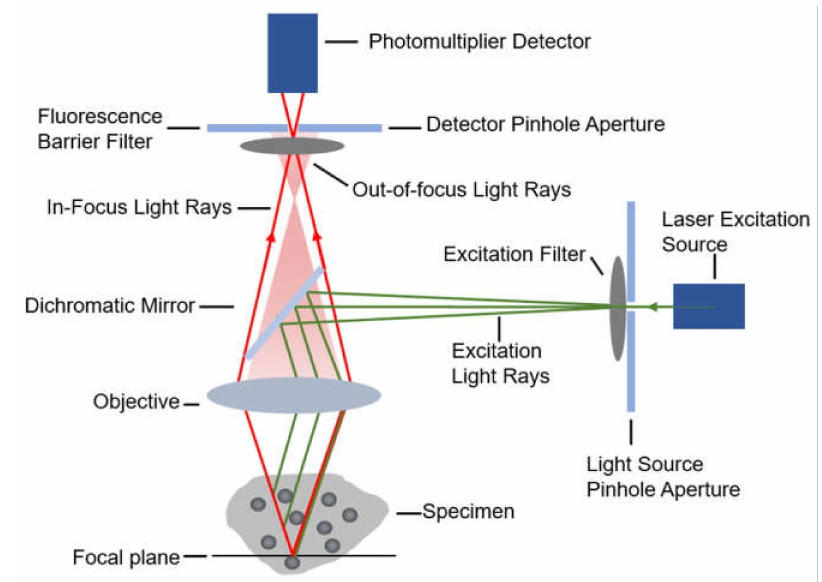
Figure 2. The diagrammatic sketch of the confocal microscope’s principle.